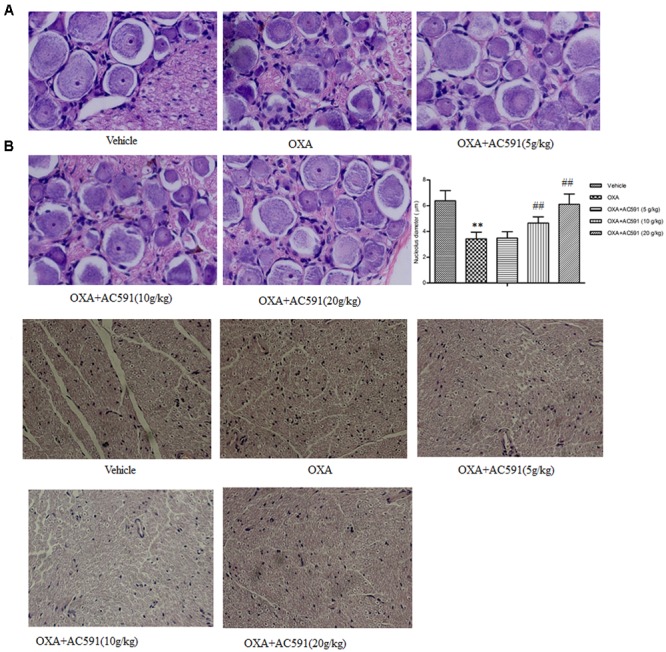
Effect of repeated administration of AC591 on histological change induced by oxaliplatin in rat DRG (A) and sciatic nerve (B). Photographs for (A) were originally magnified 400, and for (B), the photographs were magnified 100. Each value represents the mean of 5 rats per group. ∗∗P < 0.01 vs. vehicle; ##P < 0.01 vs. oxaliplatin.